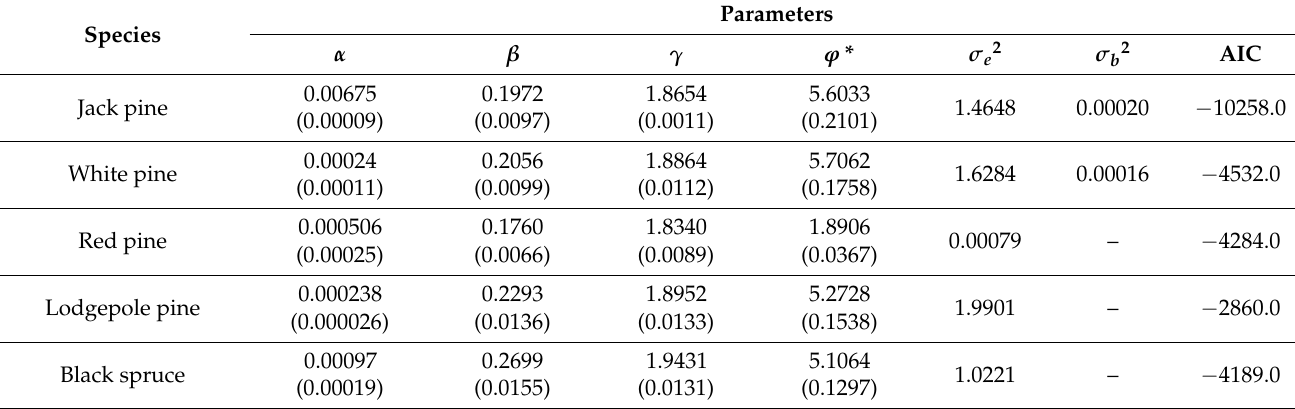
Table 2. Parameter estimates (standard error) and fit statistics (MSE ( σ e 2 ), variance of b ( σ b 2 ), and AIC (Akaike’s Information Criterion)) of Equation (10) fitted to inside bark volume data using NLMIXED procedure in SAS for 25 tree species used in this